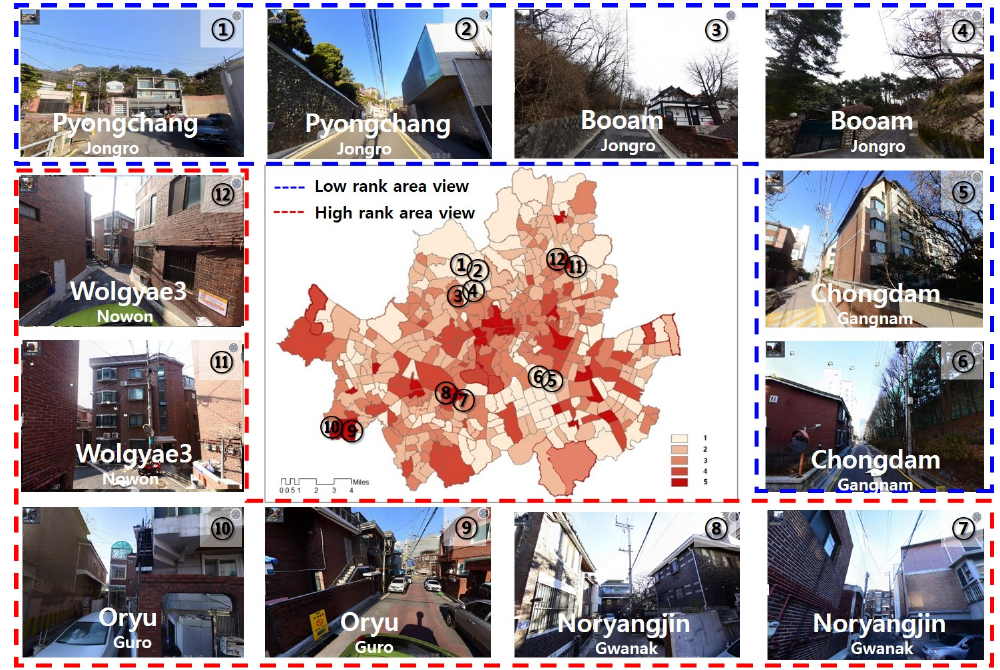
Figure 6. Street views of the relative highest and lowest sensible heat vulnerability. Note: Twelve street views for six communities representing the highest rank (the first through the third picture ① ~ ⑥ ) and the lowest rank (436th through 438th, picture ⑦ ~ ⑫ ), each of which can relate its context and situation to the community's thermal vulnerabilities.